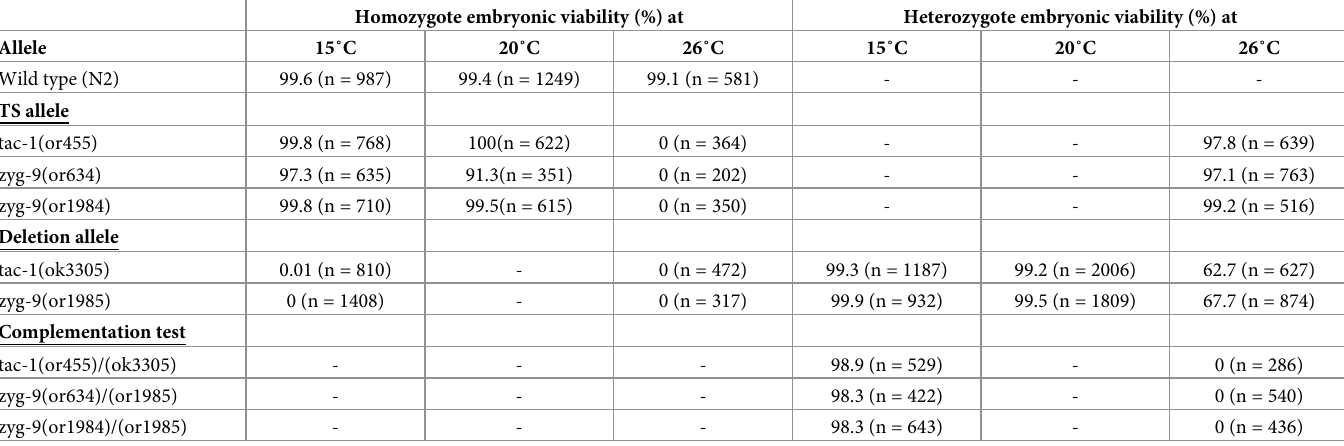
Embryonic viability in broods produced by hermaphrodites of indicated genotypes cultured at indicated temperatures. The embryonic lethality observed at 26˚C but not at lower temperatures in broods from ok3305/+ and or1985/+ hermaphrodites appears to represent maternal-effect haploinsufficiency (see Materials and